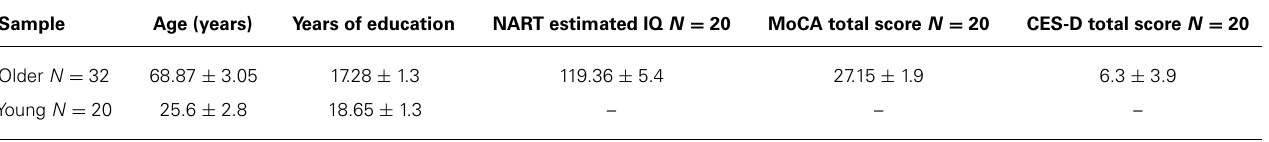
Table 1 | Characteristics of the samples recruited for this